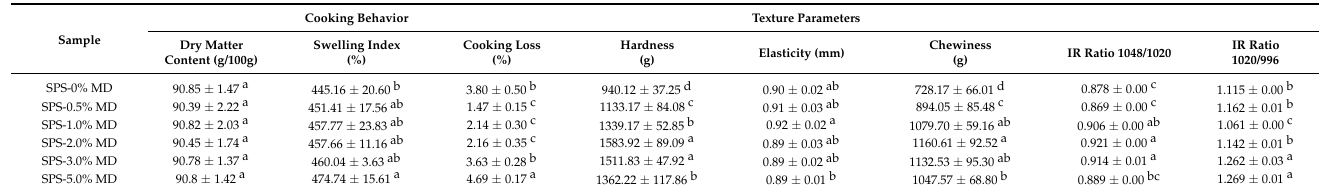
Figure 1. The FT − IR spectra ( A ) and XRD patterns ( B ) of sweet potato starch (SPS) noodles with various (0, 0.5, 1, 2, 3, and 5%, w / w ) maltodextrin (MD) concentrations. Inset: the enlarged peaks in the range of 980 − 1080 cm − 1 of each sample. Table 1. Cooking, texture properties, and FT-IR deconvolution results of sweet potato starch (SPS) noodles with various (0, 0.5, 1, 2, 3, and 5%, w / w ) maltodextrin (MD) concentrations.